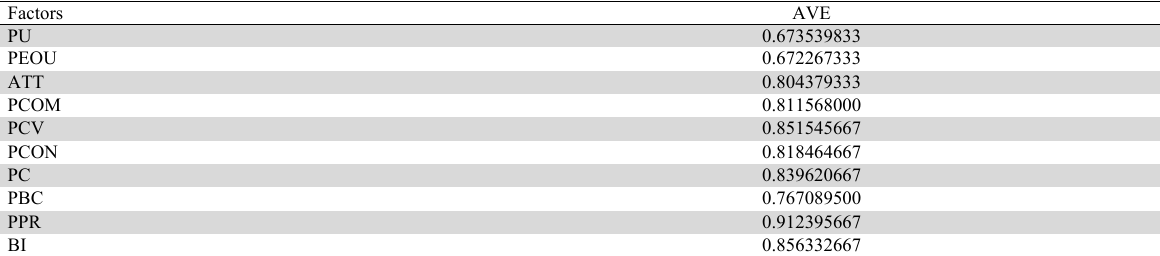
The results of AVE